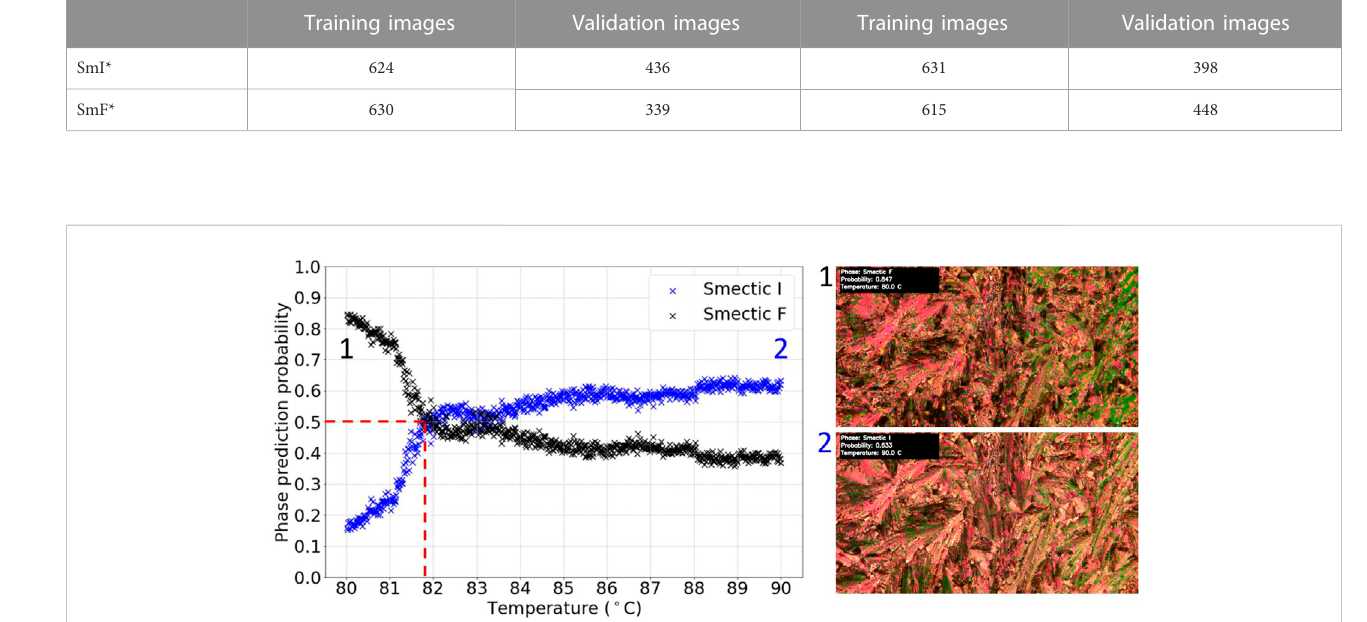
TABLE 4 Number of training and validation images for the SmI*-SmF* datasets. Phase